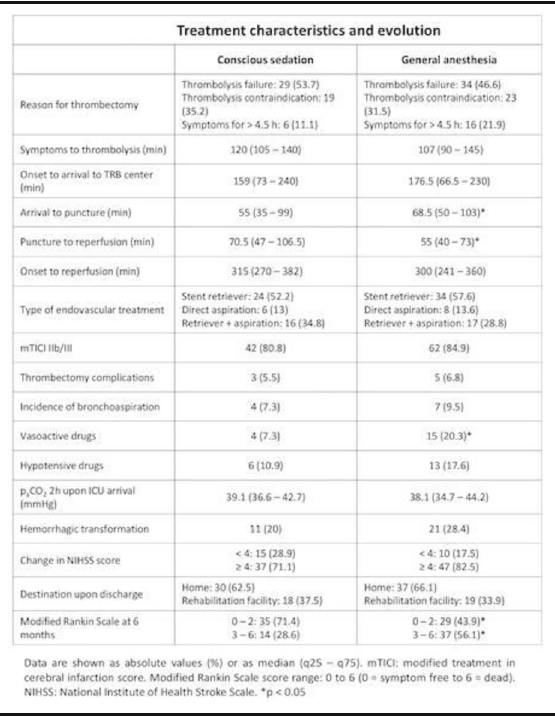
Table 2 (abstract 0035). Treatment characteristics and evolution